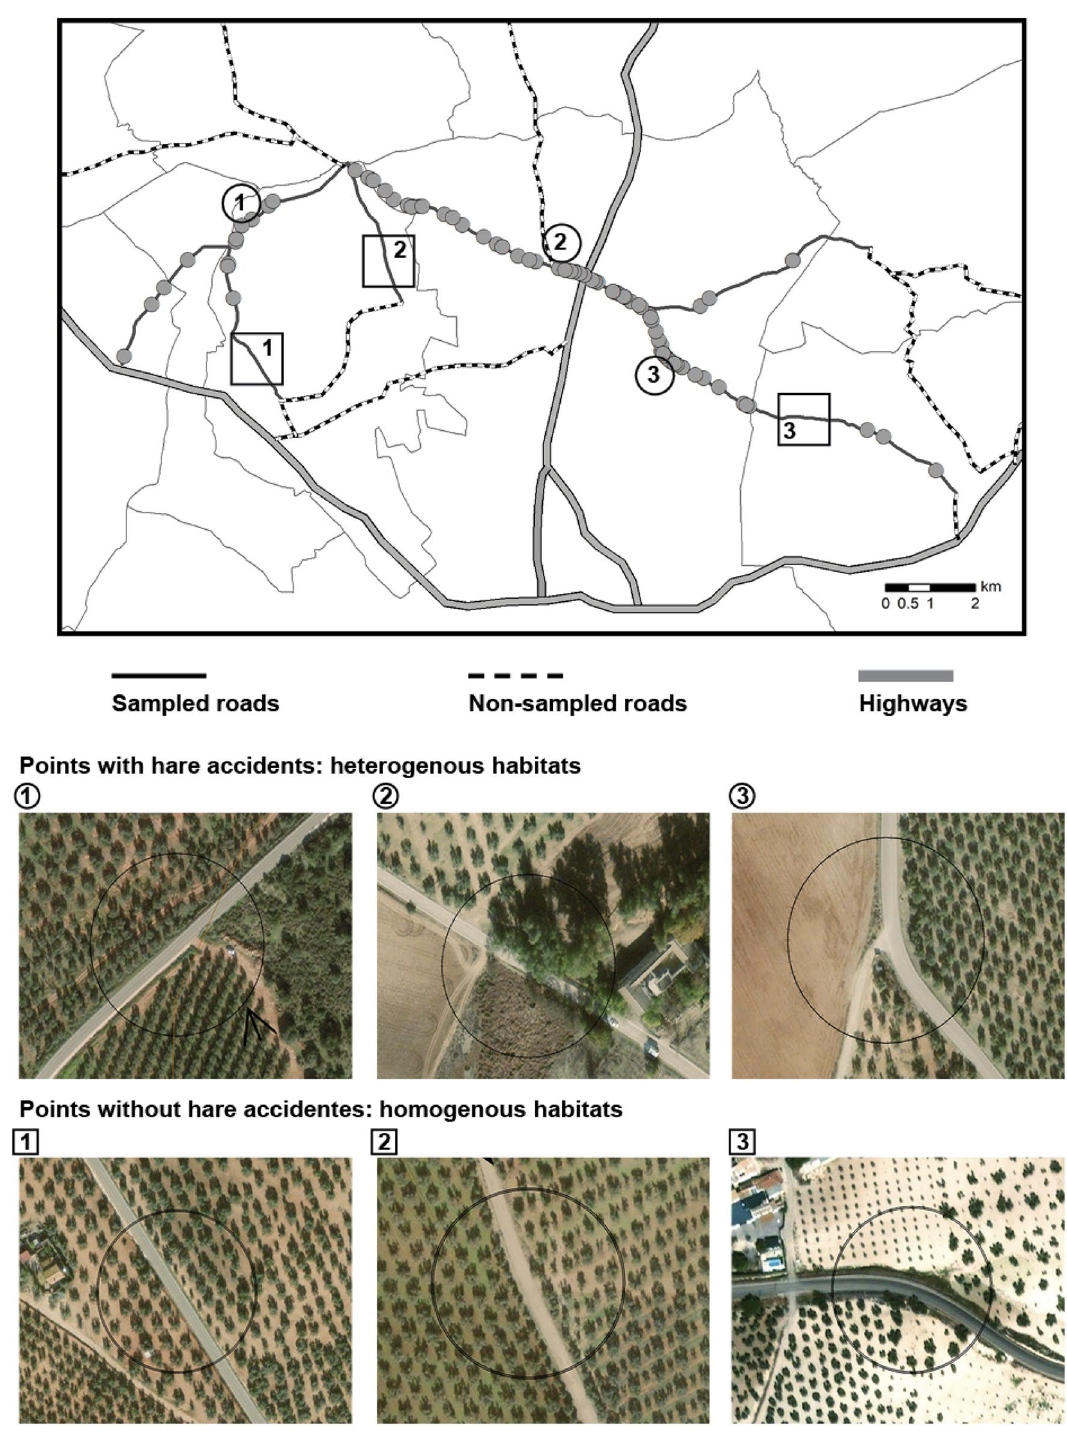
Figure 3. Representative points along the sampled road network with (heterogeneous habitat) and without (homogeneous habitat) hare accidents. Photographs show habitat within a 100 m buffer around each point; grey circles indicate points with hare roadkill events. Map created with ArcGis 9.3 (ESRI 2008). Datasets from Instituto de Estadística y Cartografía de Andalucía, Junta de Andalucía. Road network and administrative boundaries (https:// www. idean daluc ia. es/ catal ogo/ inspi re/ srv/ spa/ catal og. searc h#/ home) Ortophotography (https:// www. junta deand alucia. es/ insti tutod eesta disti cayca rtogr afia/ prodC artog rafia/ ortof otogr afias/ index.